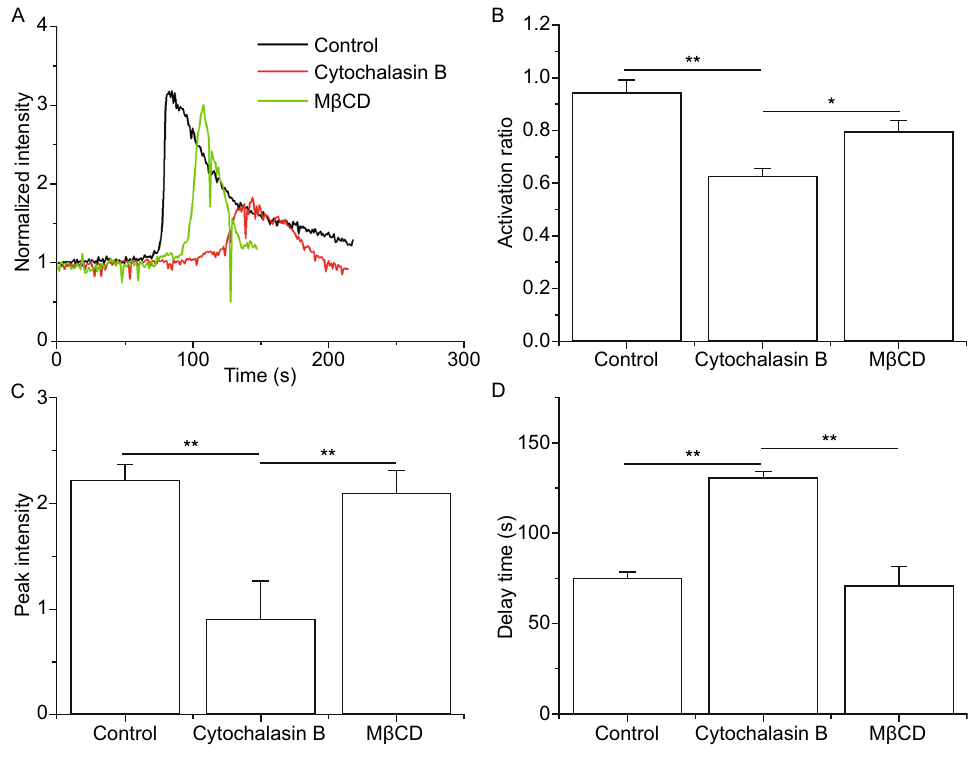
Figure 6. Effects of cytoskeleton actin depolymerization and lipid raft disruption on calcium signaling of neutrophils on P-selectin in fl ow. The time-course (A), activation ratio (B), peak intensity (C) and delay time (D) of P-selectin-induced calcium signaling of neutrophils, treated with or without cytochalasin B (cytoskeleton actin depolymerization agent) and M β CD (membrane lipid rafts disruption), at a wall shear stress of 0.2 Pa. The data represent the mean ± SEM from at least 20 cells in 3 independent experiments. The signi fi cant level of difference from the control group (the cells treated with nothing) is shown by P -value, * P < 0.05, ** P